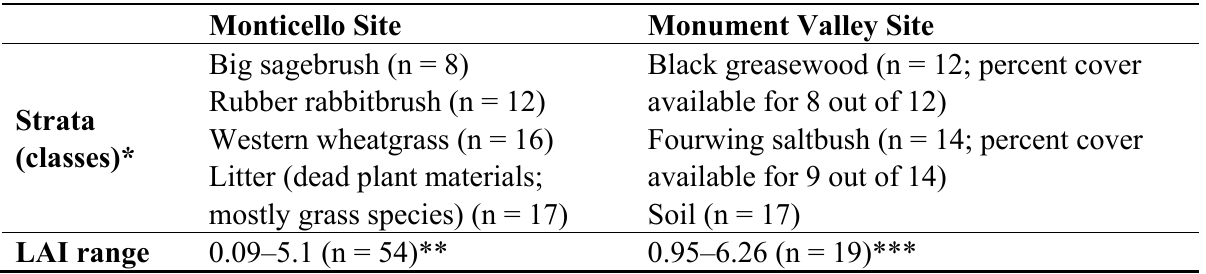
Table 1. Field data characteristics for vegetation mapping and leaf-area-index (LAI)